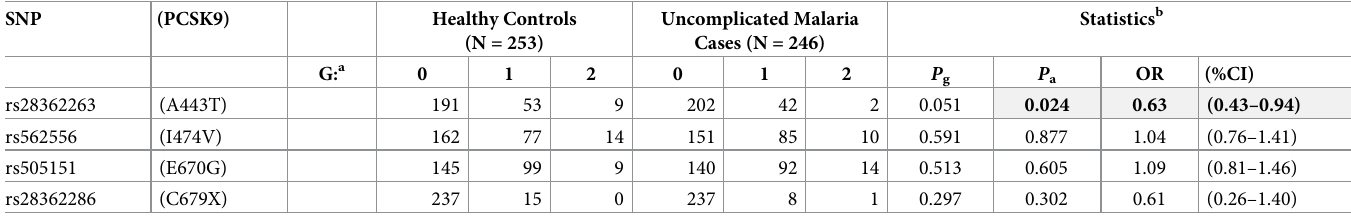
Table 4. Association analysis of PCSK9 SNPs and uncomplicated